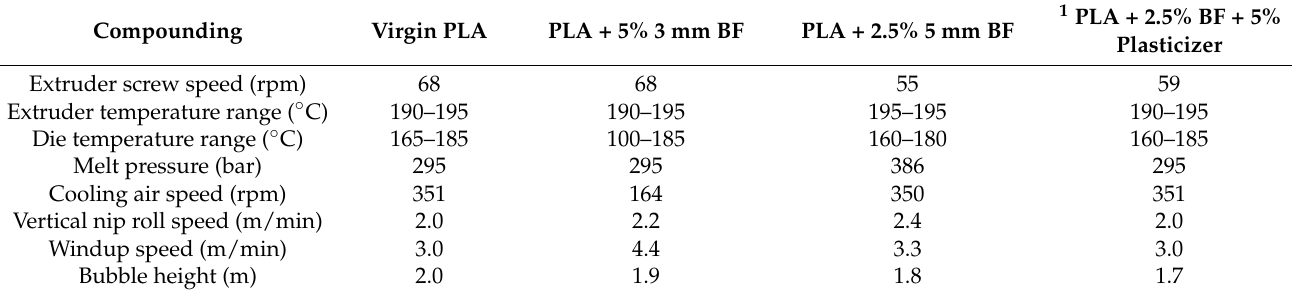
Table 8. Optimal film blowing parameters of the preliminary